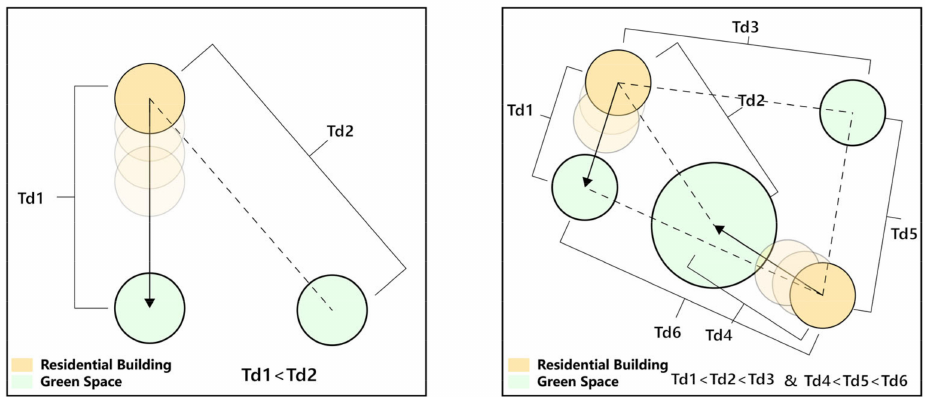
Figure 4. The mechanism of the Shortest Time Distance